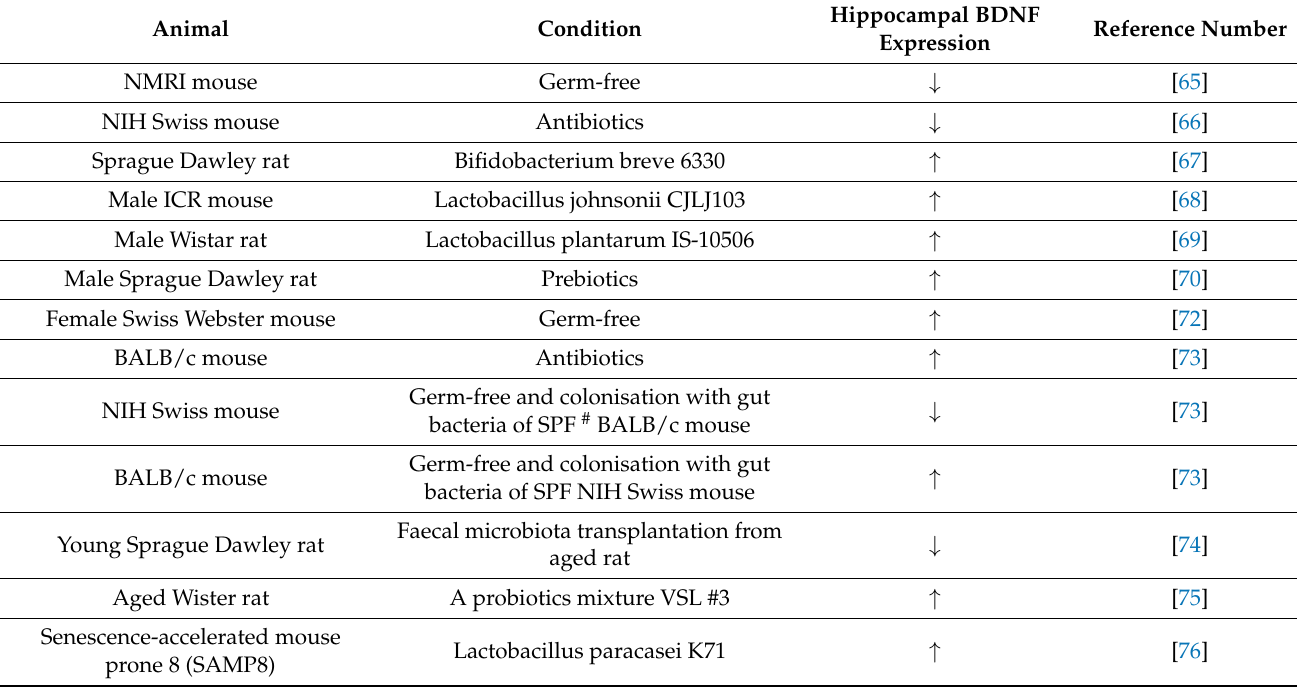
Table 1. Effects of gut bacteria on hippocampal BDNF